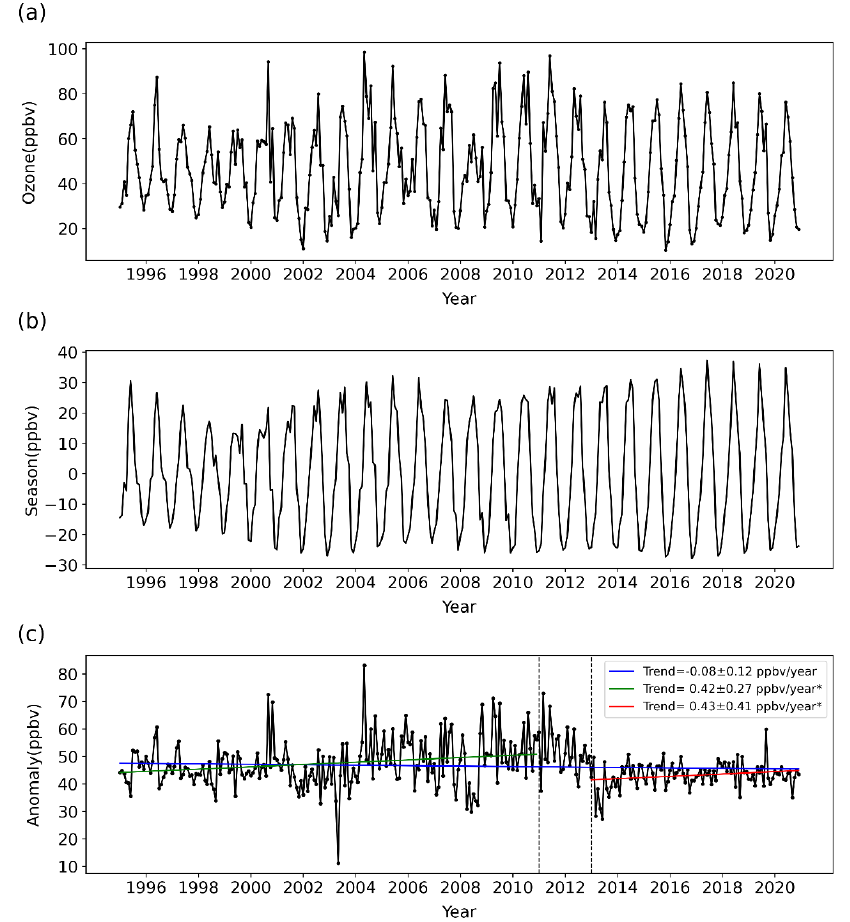
Figure 6. ( a ) Monthly mean surface ozone mixing ratio in Beijing for 1995–2020 after filling missing values. ( b ) The seasonal component decomposed by STL from time series of surface ozone mixing ratio. ( c ) Monthly mean surface ozone anomalies calculated by subtracting seasonal component and its linear trends during 1995–2020 (solid blue line), before 2011 (solid green line) and after 2013 (solid red line). The trends with “*” passed the 95 % significance test.